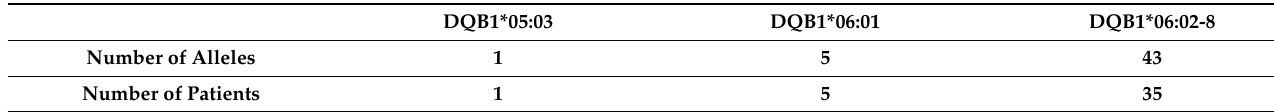
Table 4. Characteristics of patients carrying presumably protective (DQB1*06:01) and